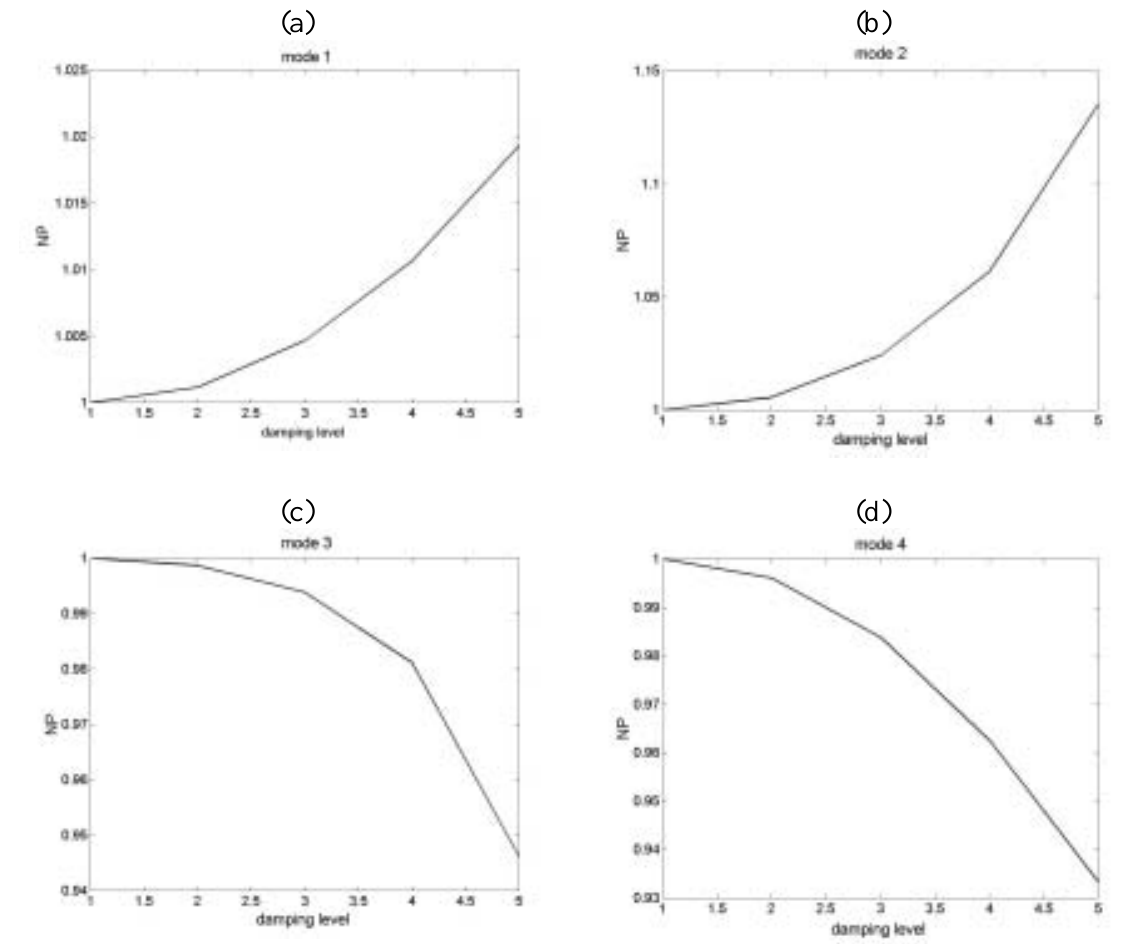
Fig. 3. Modal index of non-proportionality NP versus damping level χ (five equally spaced damping levels from χ = 1 to χ 5 = 801 ) for mode 1 (a), mode 2 (b), mode 3 (c) and mode 4 (d). completely different root